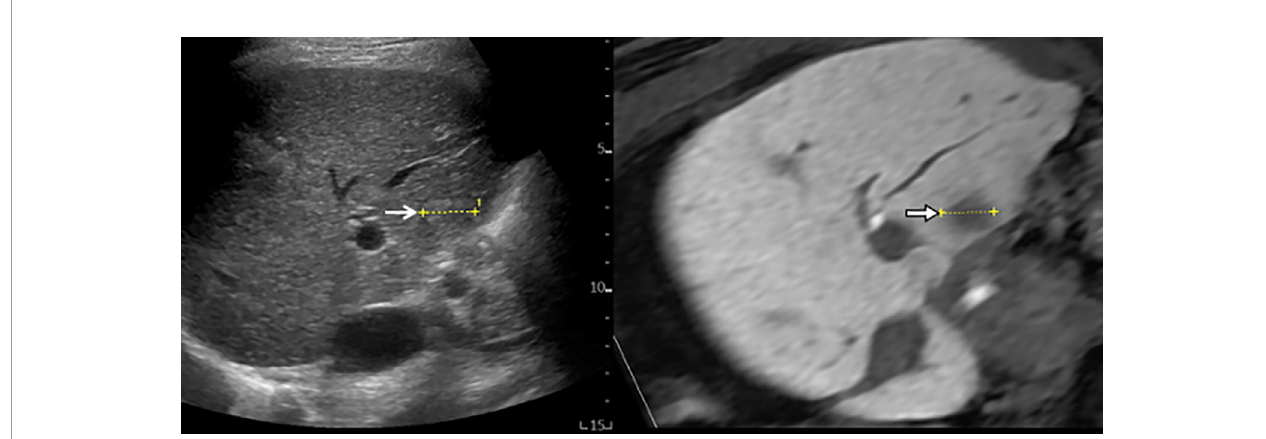
FIGURE 1 | MR-US fusion imaging. MRI and US images with HCC measuring 1.8 cm in diameter are well-matched. B-mode US (left) shows a slightly hyperechoic nodule with ill-de fi ned HCC (open arrow) from intercostal view. Hepatobiliary phase image of gadoxetic acid-enhanced MRI (right) shows low signal intensity with ill- de fi ned HCC